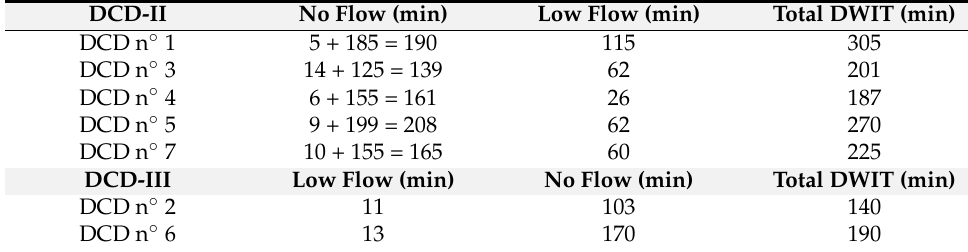
Table 1. DCD warm ischemia